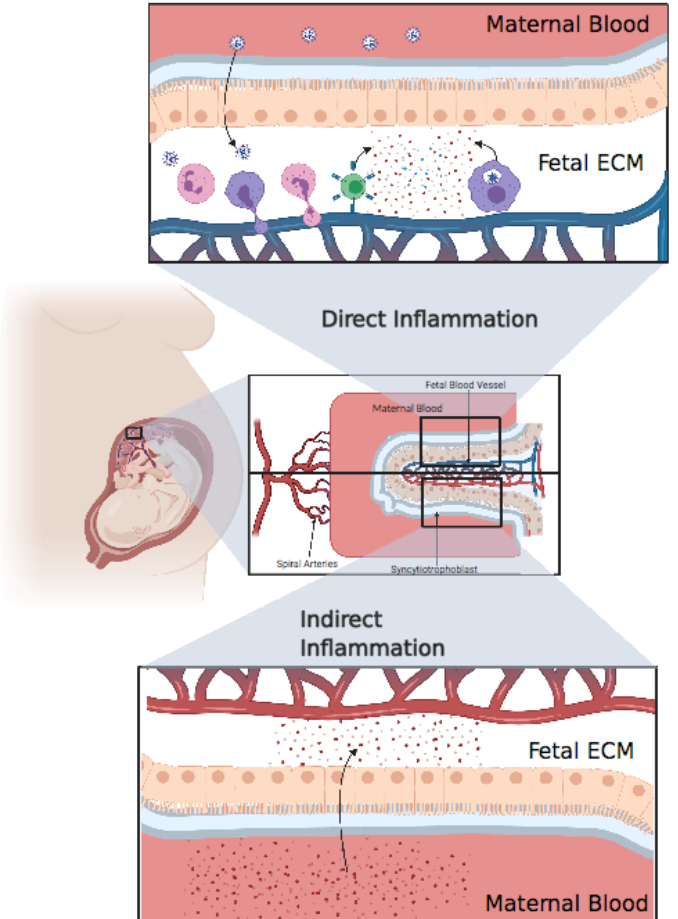
Figure 3. Direct inflammation or indirect inflammation. Direct inflammation: after viral invasion of the placenta, fetal immune cells, including neutrophils, monocytes, and T cells, extravasate from fetal blood to the placental extracellular matter, resulting in an extensive inflammatory response in the fetal extracellular matrix (ECM). Finally, these inflammatory cytokines pass through the blood, resulting in systemic inflammation in the fetus. Indirect inflammation: inflammatory cytokines circulating in maternal blood after a cytokine storm might pass through the placenta, resulting in indirect inflammation. Created with